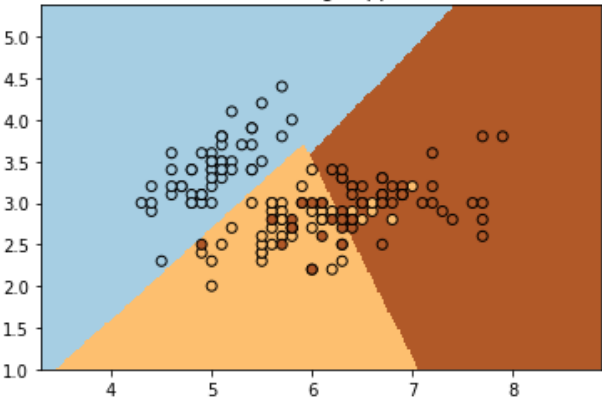
Figure 6. Support Vector Machine Example (After